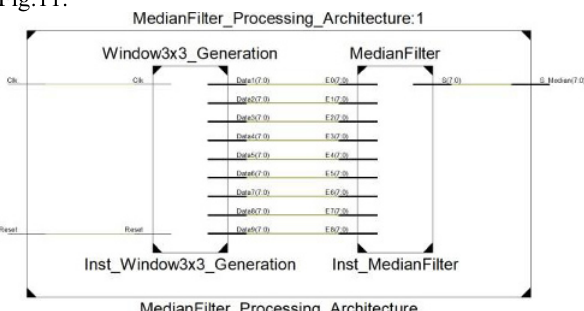
Fig. 9. RTL Schematic for the complete architecture